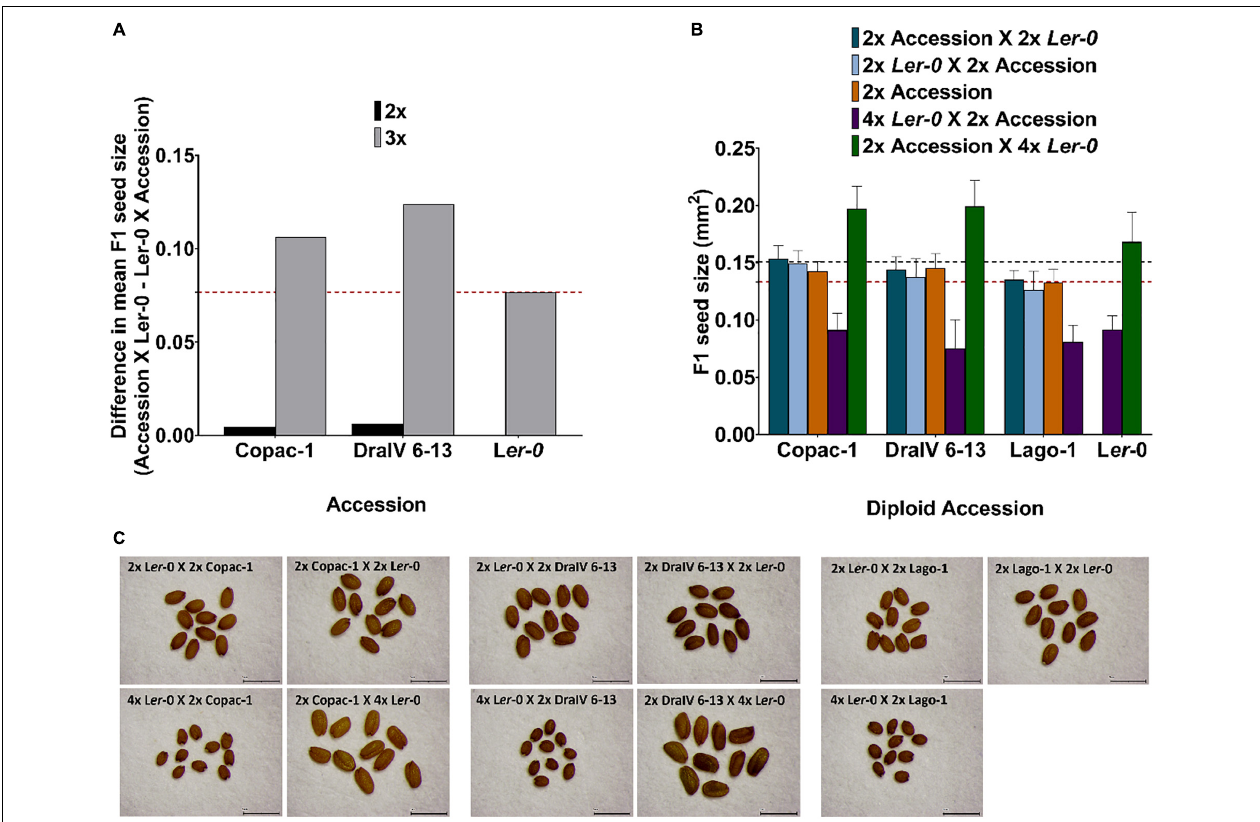
FIGURE 4 | Hybridity enhances parent-of-origin effects in F1 triploids beyond that achieved at the diploid level. (A) Difference in F1 mean seed size for reciprocal isogenic (L er -0) and hybrid crosses at the diploid and triploid level. The red dashed line represents the parent-of-origin effects for L er -0 F1 isogenic triploids. (B) F1 hybrid seed size of balanced-ploidy crosses (2x Accession X 2x L er -0 and 2x L er -0 X 2x Accession) and inter-ploidy crosses (2x Accession X 4x L er -0 and 4x L er -0 X 2x Accession). Seed size of parental lines is also represented (orange for the natural accessions, a horizontal red dashed line for 2x L er -0 and black dashed line for 4x L er -0) for comparison with ploidy levels and their reciprocal F1 offspring. Error bars represent SD. (C) Seed size phenotypes of reciprocal F1 seeds in balanced and inter-ploidy crosses. Scale bar =